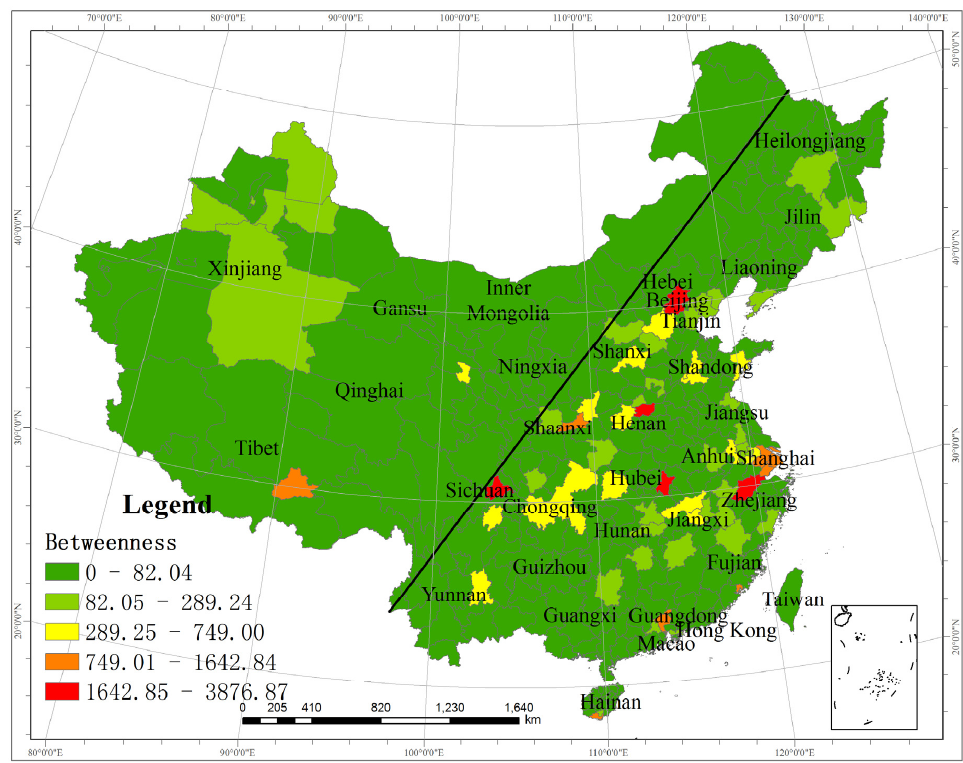
Figure 9. Betweenness centrality of the tourism information flow network in